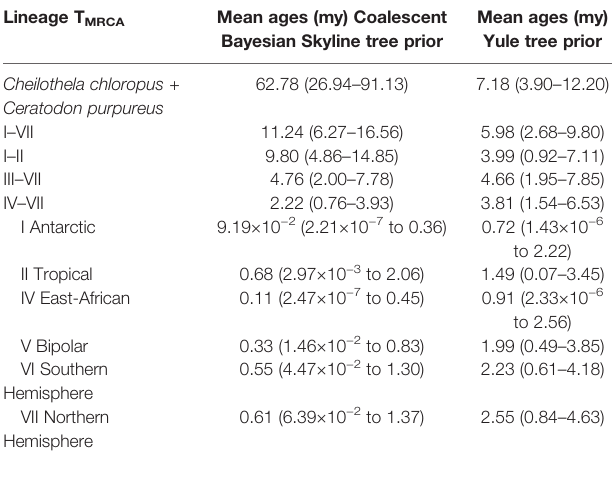
Figure 2A ) of Ceratodon purpureus , as calculated in BEAST.